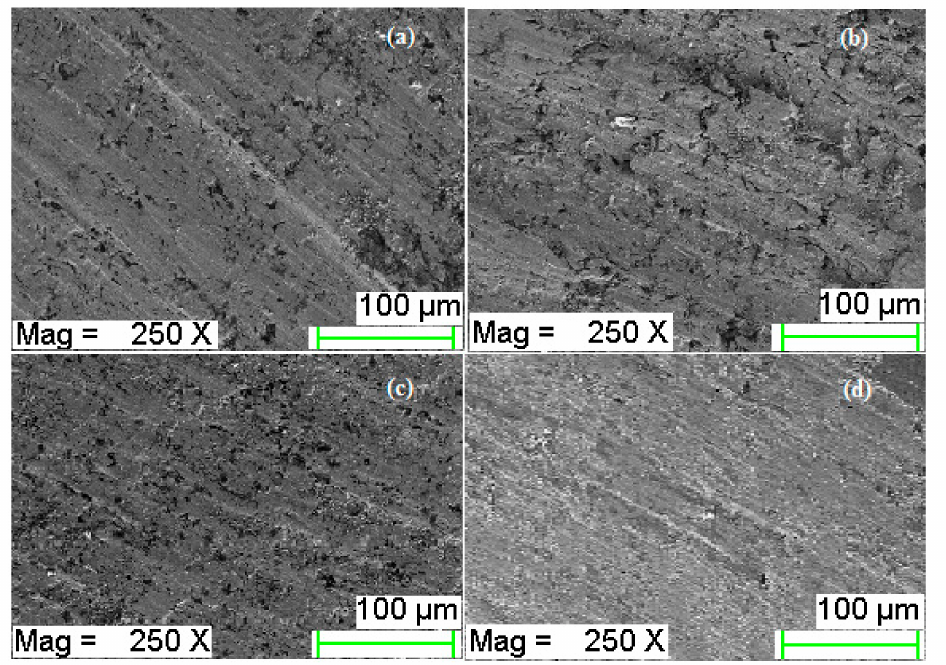
Figure 11. ( a ) Counter-body micrograph after wear test at 28 ◦ C and 10 N, ( b ) counter-body condition after wear test at 100 ◦ C and 20 N, ( c ) counter-body condition after wear test at 200 ◦ C and 30 N, ( d ) counter-body condition after wear test at 300 ◦ C and 40